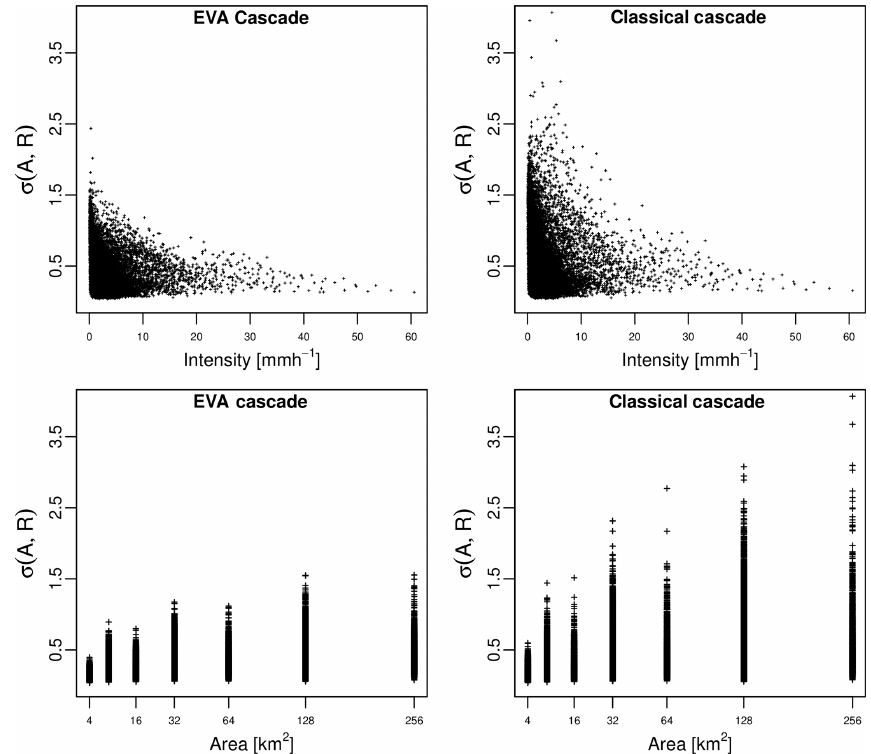
Figure 8. Standard deviation of empirical breakdown coefficients for the 100 radar snapshots in the database as a function of the rainfall intensity R and area A of grid